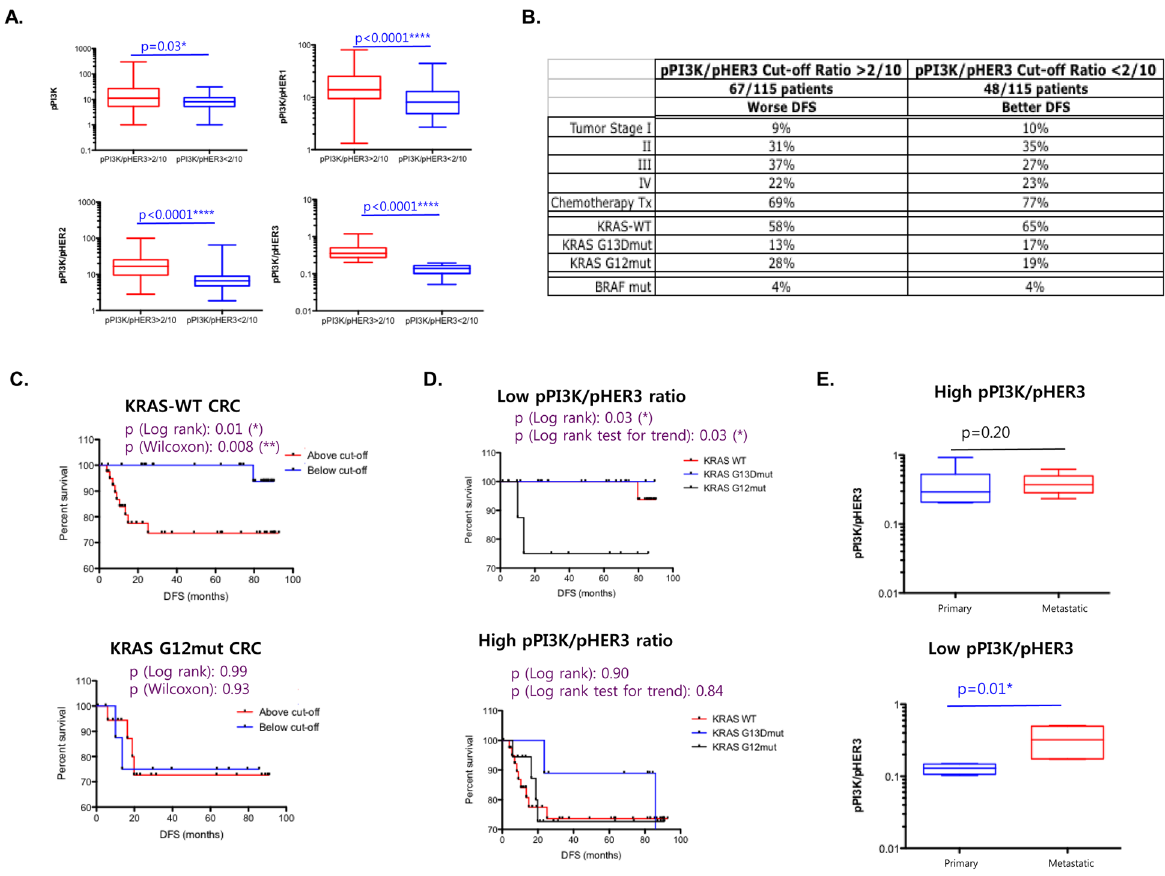
Figure 2. PI3K signaling in colorectal cancers (CRCs). The respective p-values are indicated. (A) Box plots of the Mann–Whitney t -test showing the difference in the expression of pPI3K, pPI3K/pHER1, pPI3K/pHER2, and pPI3K/pHER3 between the high pPI3K/pHER3 group and low pPI3K/pHER3 groups. The respective p-values are indicated. (B) Table listing the characteristics of primary CRCs in high PI3K (high pPI3K/pHER3) versus low PI3K (low pPI3K/pHER3) signaling cohorts. Characteristics include segregations based on tumor stage, status of chemotherapy treatment, and mutational status of KRAS and BRAF . Altogether, 67/115 samples are included in the high PI3K cohort and 48/115 samples are included in the low PI3K cohort. The numbers indicate the percentage of samples within each cohort based on each indicated characteristic. (C) DFS according to pPI3K/pHER3 ratios in KRAS WT and KRAS G12mut CRCs. (D) Kaplan–Meier survival curves of high PI3K (pPI3K/pHER3) and low PI3K cohorts comparing the DFS of KRAS WT, G13Dmut, and G12mut samples. (E) high PI3K (high pPI3K/pHER3) and low PI3K (low pPI3K/pHER3) groups in paired primary and metastatic CRC samples. the pPI3K/pHER3 ratio (Fig. 2A). Patient characteristics in the high vs. low pPI3K signaling CRC cohorts were well balanced in terms of their tumor stage, chemotherapy treatments, and mutational status of the oncogenes KRAS and BRAF (Fig. 2B).